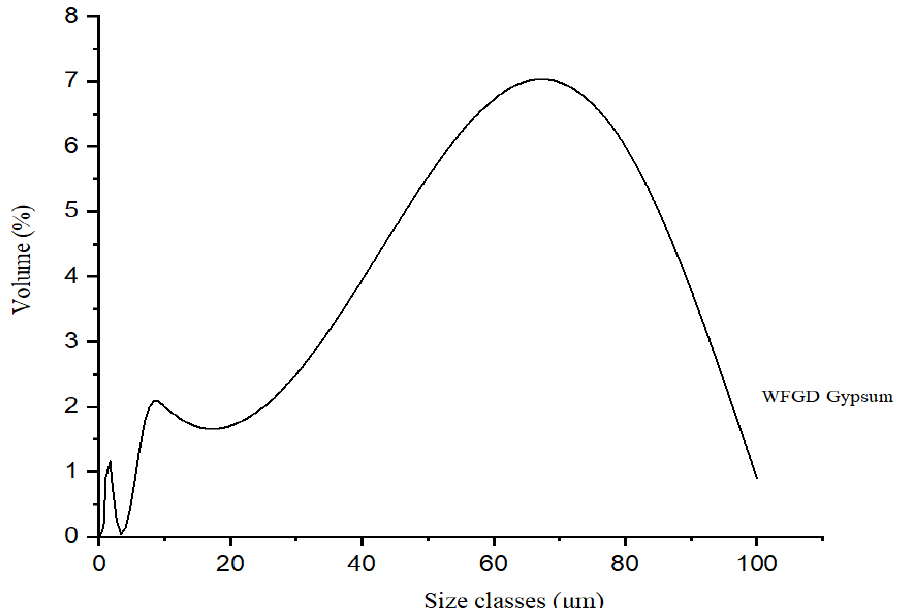
Figure 5. Volume particle size distribution of WFGD gypsum.